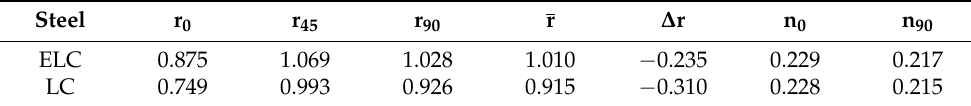
Table 3. r value and n value of different C content.